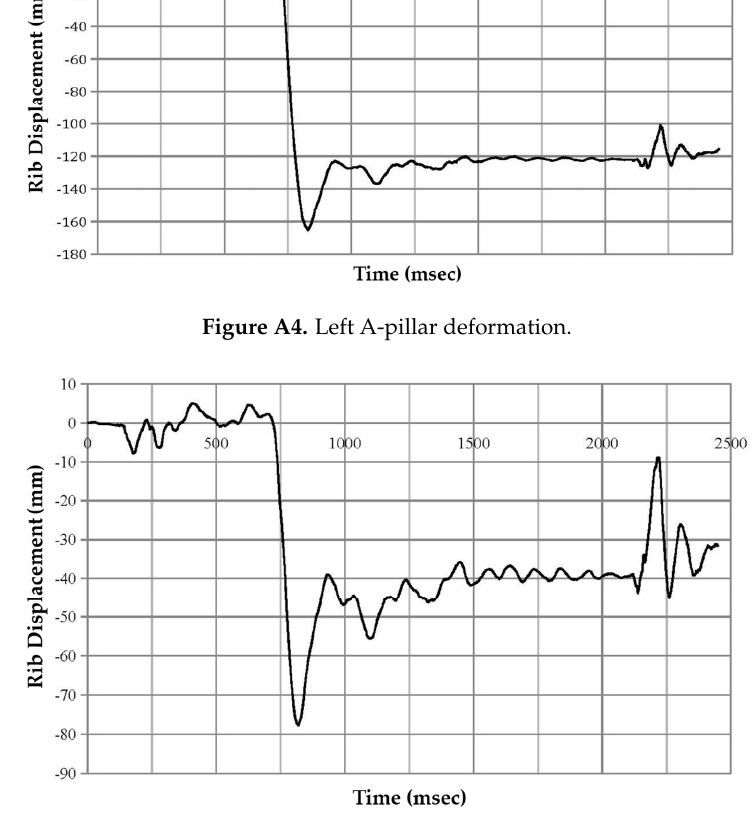
Figure A5. Left B-pillar deformation.